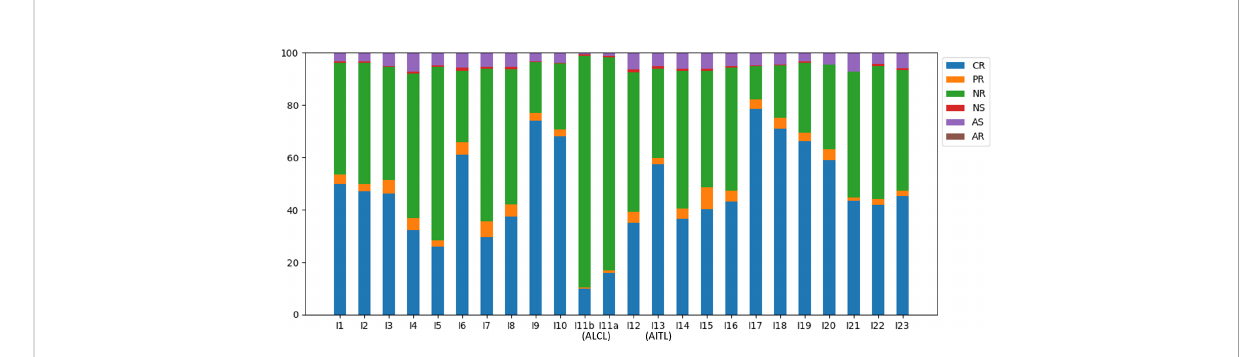
FIGURE 2 Compositions of the TCR b reads in the six categories across all samples.